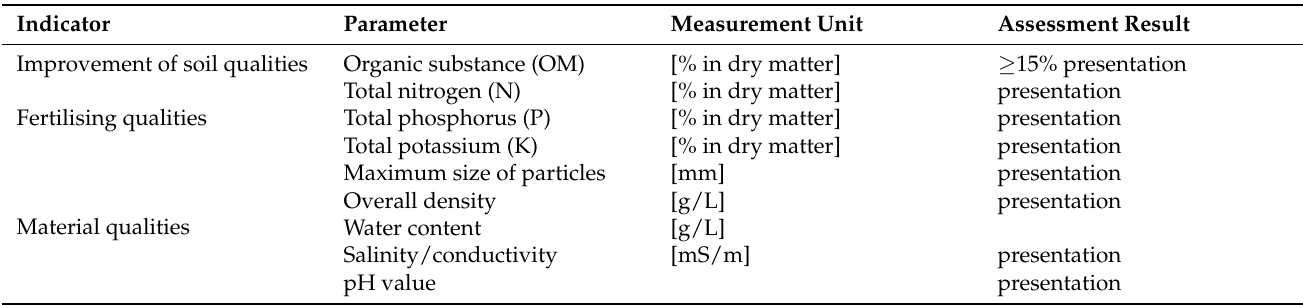
Table A1. “Indicators to be measured and presented.“ from the Regulation of the Republic of